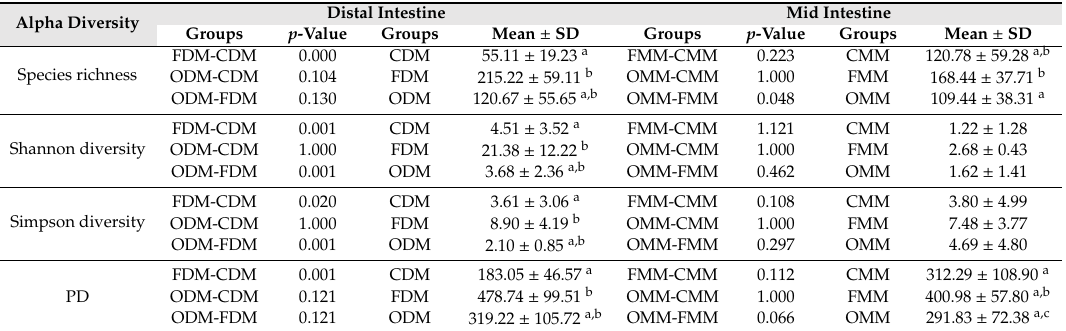
Table 1. Species richness and Shannon and Simpson diversity of bacterial communities in the control and antibiotic fed groups.